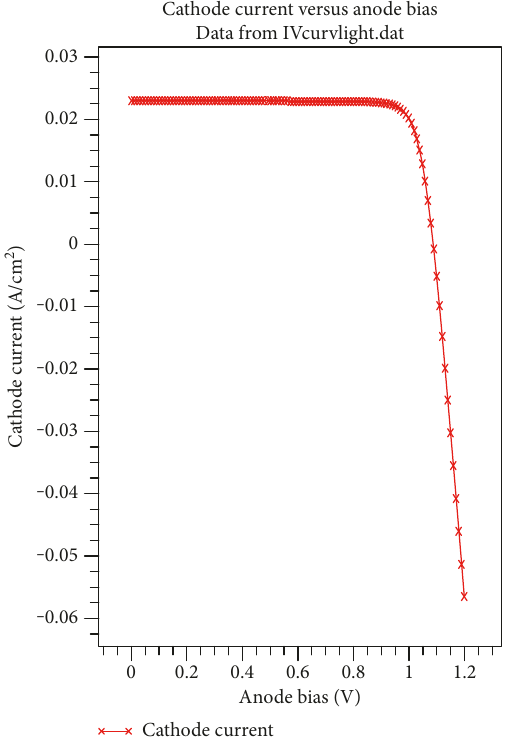
Figure 4: I - V characteristics of the initial model.